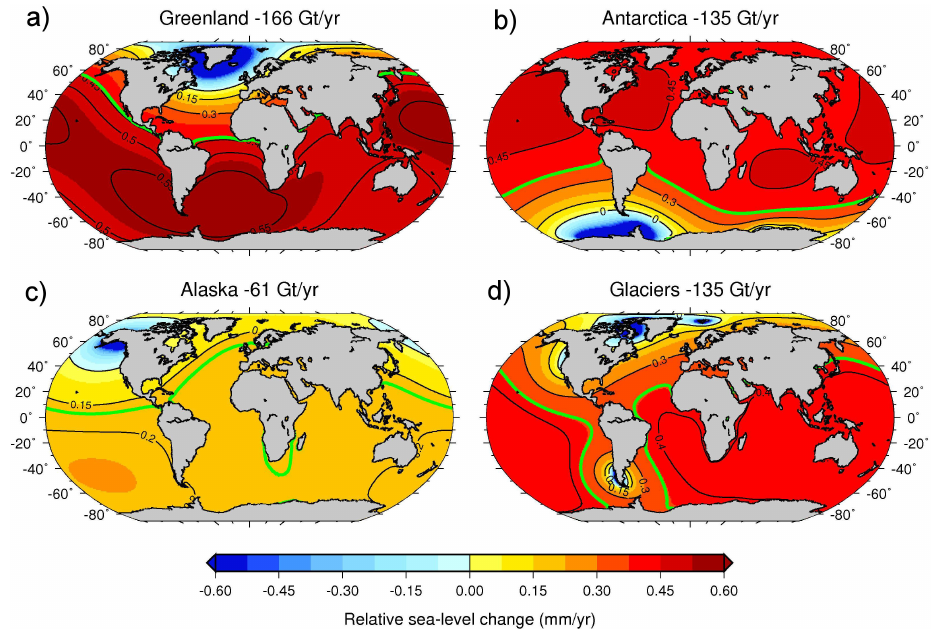
Fig. 2. Relative sea level variations due the gravitational and Earth rotational effects of ice mass losses from different sources for the period 2000–2008 inclusive; (a) Greenland, (b) Antarctica, (c) Alaska, (d) mountain glaciers and ice caps in the Arctic, Patagonia and Rockies. The thick green contour indicates the global average eustatic RSL for each